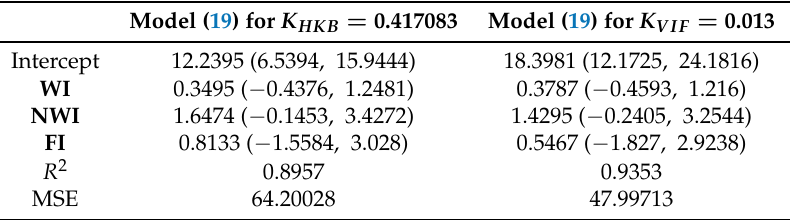
Table 11. Estimation of the ridge models for K HKB = 0.417083 and K VIF = 0.013. Confidence interval, at 10% confidence, is obtained from bootstrap inside the parentheses, and R 2 is the coefficient of determination obtained from Rodríguez et al. [28].